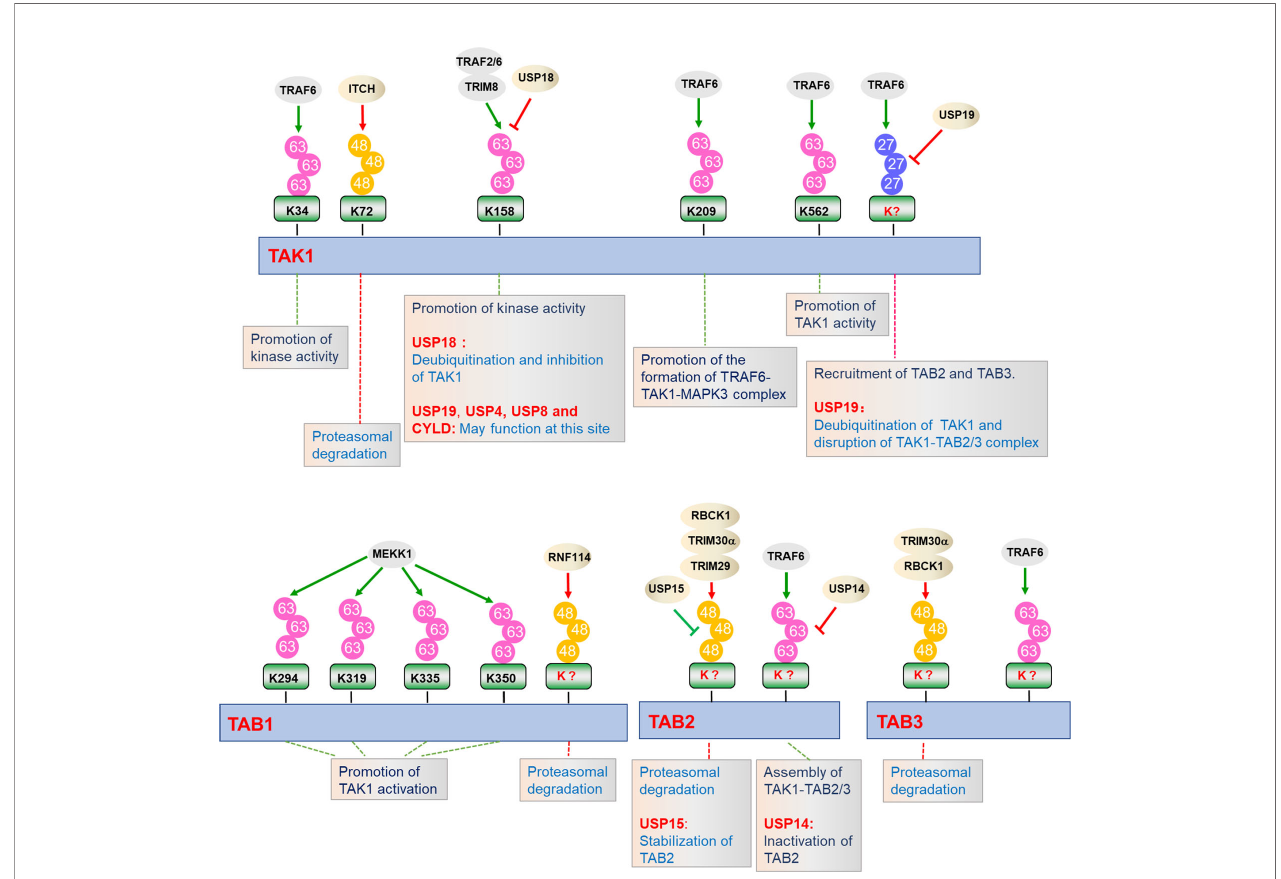
FIGURE 3 | Regulation of TAK1-TABs complex by ubiquitination. TAK1-TABs complex are dynamically modi fi ed with K27-, K48-, and K63-linked polyubiquitination by the indicated E3 ubiquitin ligases or deubiquitinating enzymes, which play important roles in regulating the stability, assembly, and activation of TAK1-TABs